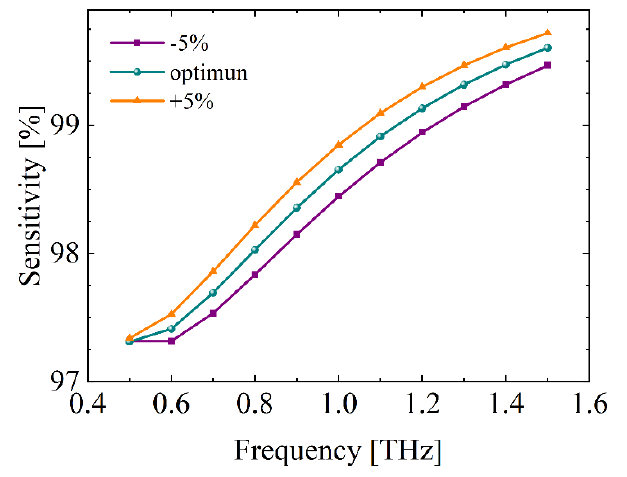
Figure 8. Sensitivity relative to frequency for an optimal structure and ± 5% variation in size.